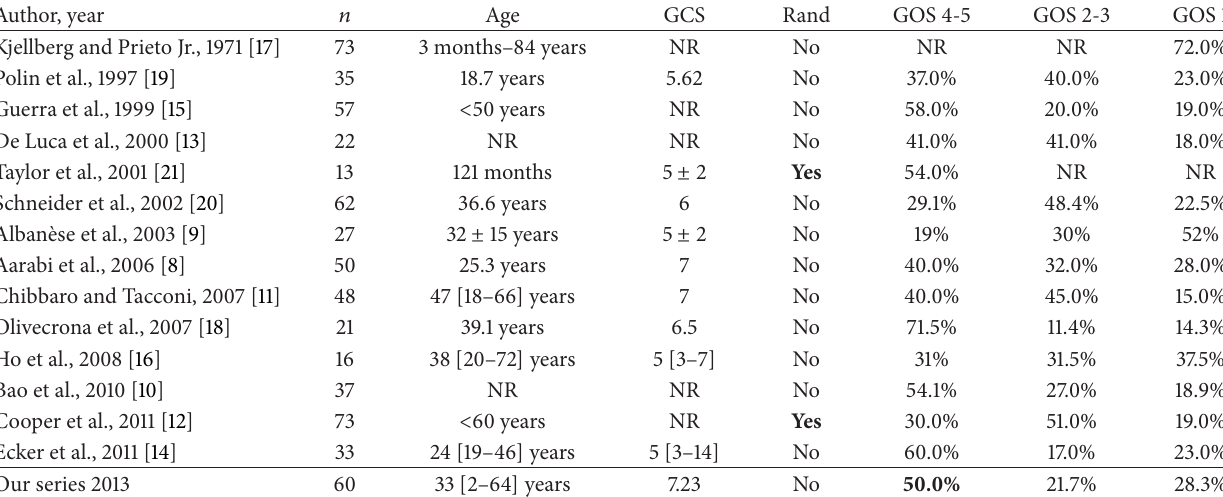
Table 5: Review of the literature presenting the various series of decompressive craniectomies performed in the setting of severe traumatic brain